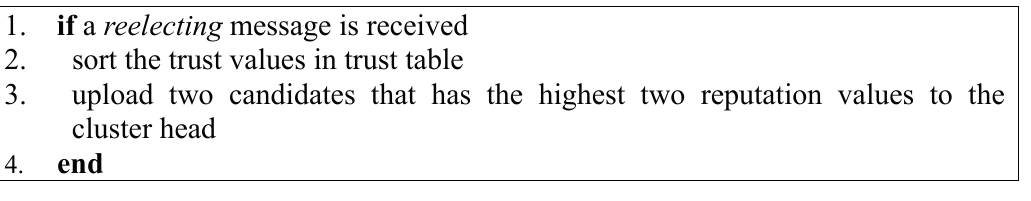
Figure 6. Procedure performed by ordinary sensor